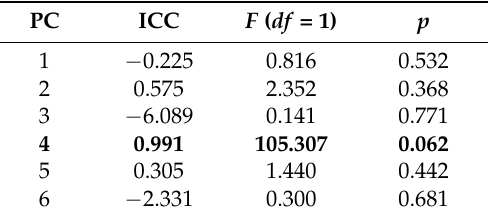
Table A6. Intraclass correlation coefficients (ICC) calculated to provide estimates of the broad-sense heritability of population differences in male body coloration in the Tacotalpa drainage. We calculated population means for each PC score and ran a 2-way mixed effects model, testing for consistency [105]. The values indicating high consistency (ICC > 0.8 [109]) are highlighted in